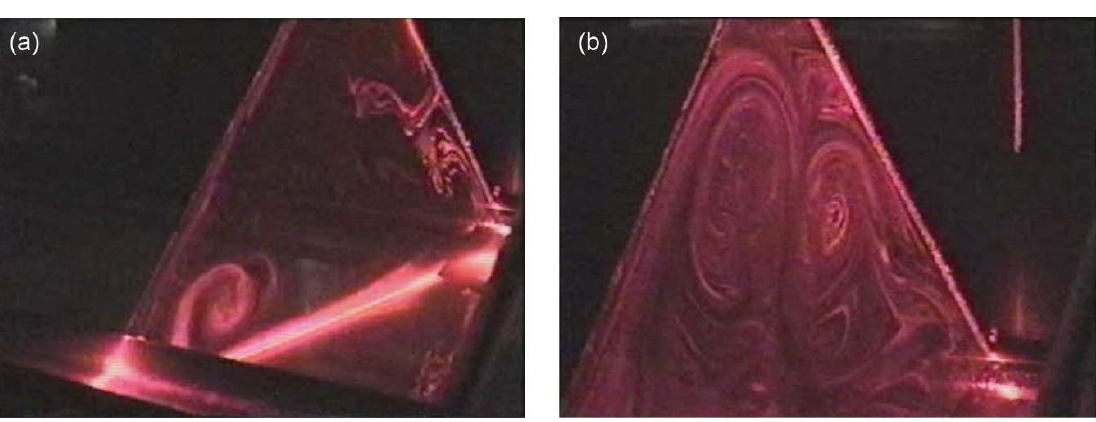
Figure 9. Visualization experiments of the convection flows in a cavity similar to those used in solar distillation. Natural convection begins ( a ) and steady-state convection ( b ).